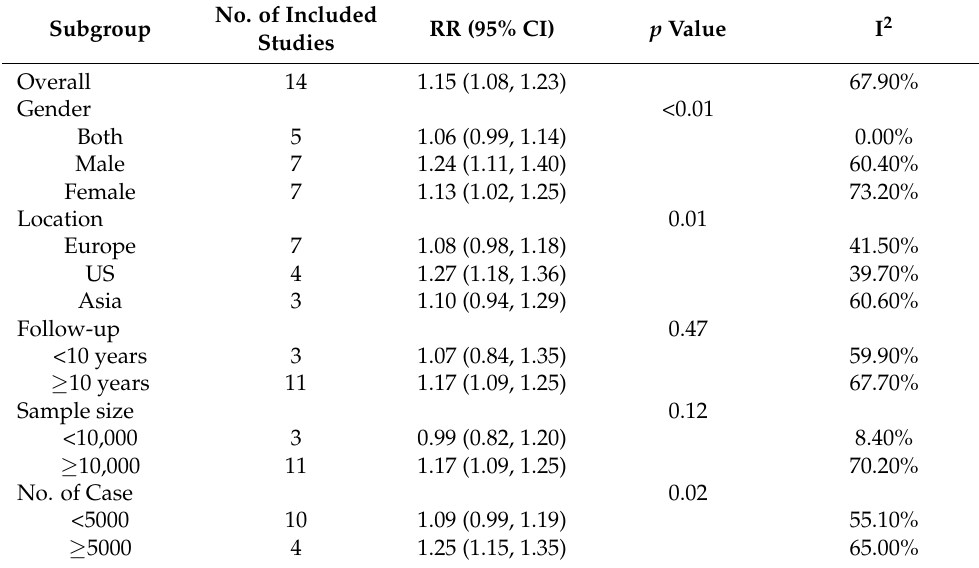
Table 2. The association between URM intake and risk of